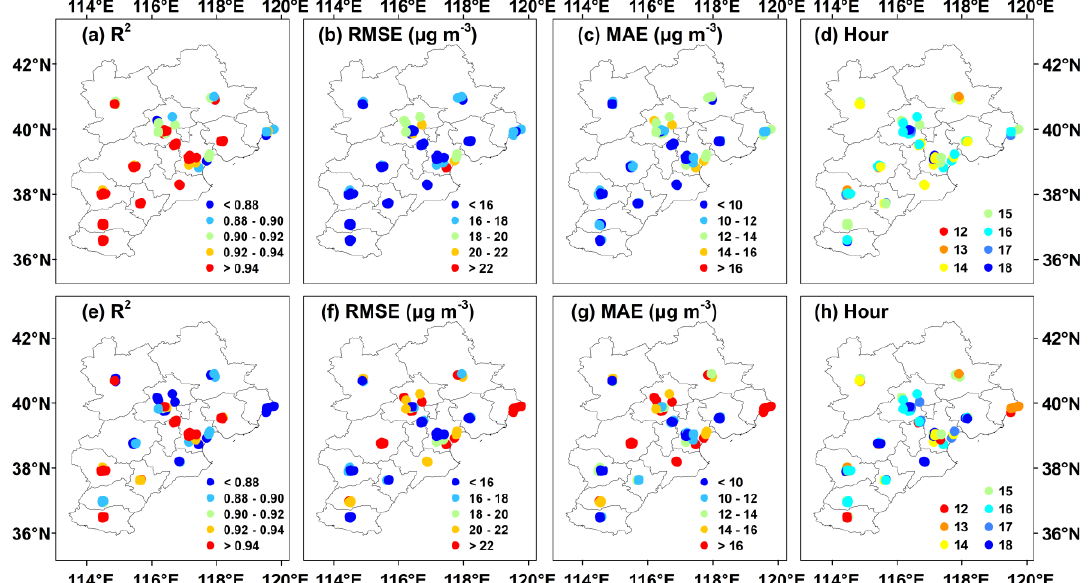
Figure 3. Site-scale evaluation of the estimated hourly O 3 concentration in 2018 across the BTH region. The upper and lower rows indicate the sample- and station-based 10-CV results, respectively. The columns from left to right indicate R 2 , RMSE, MAE and hour of occurrence of the highest 10-CV R 2 value.